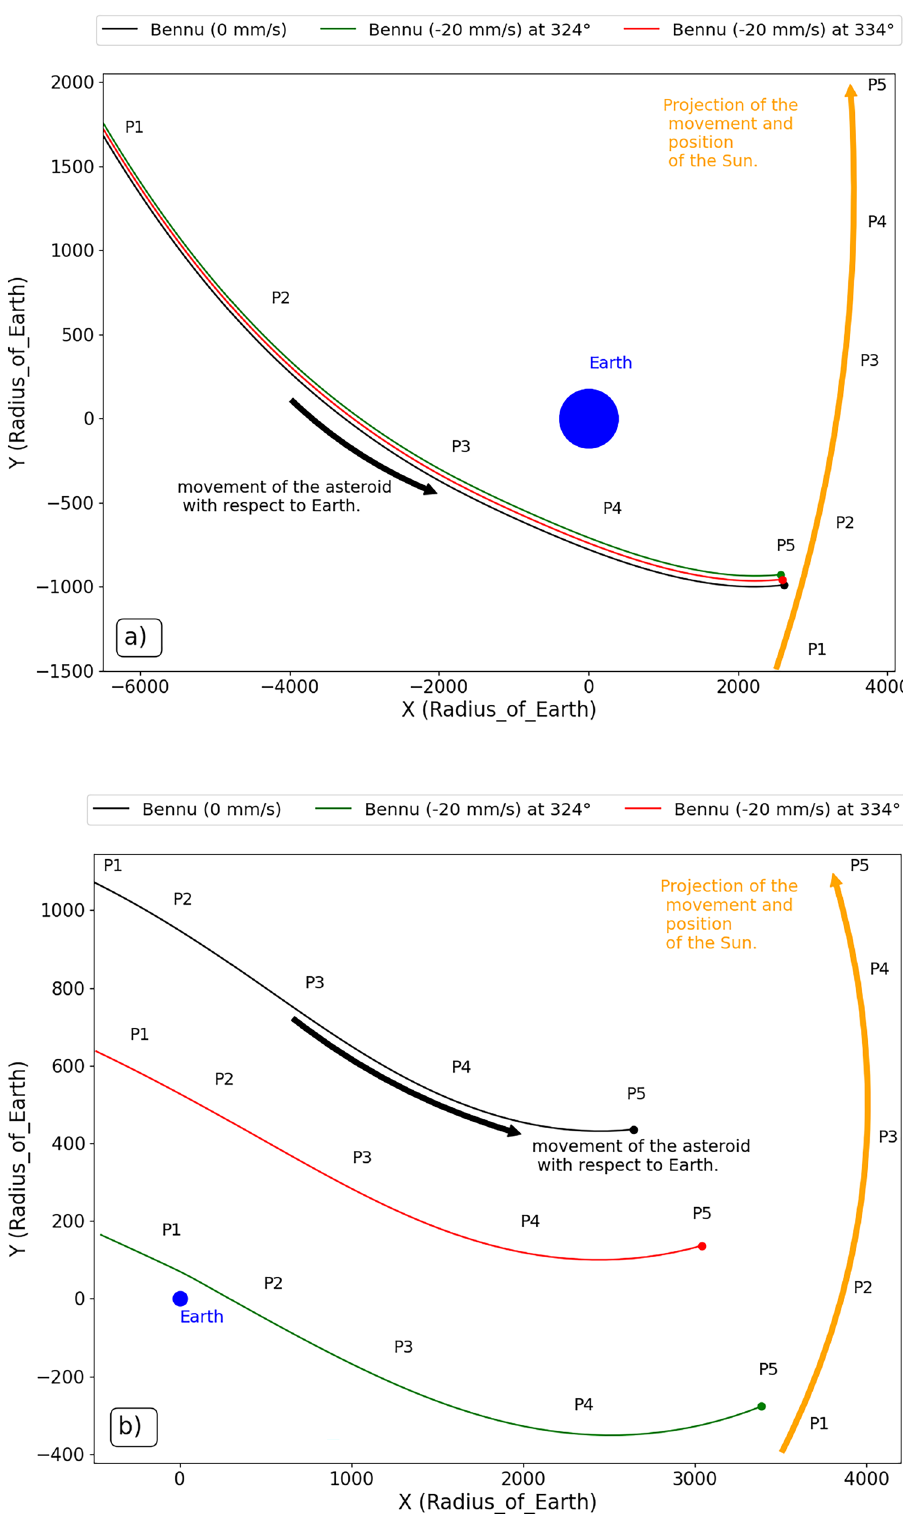
Figure 11. The position of the asteroid relative to the Earth without impulse and with an impulse of −20 mm/s applied at the mean anomalies 324° (green line) and 334° (red line), for the second largest encounter with Earth in 2005, approximately 25 years after the impulse ( a ) and for the largest close encounter between the asteroid and the Earth in 2054, between 70 and 80 years after the impulse ( b ). We call P1, P2, P3, P4 and P5 the relative positions between the asteroid and the Sun, which is shown with respect to the Earth